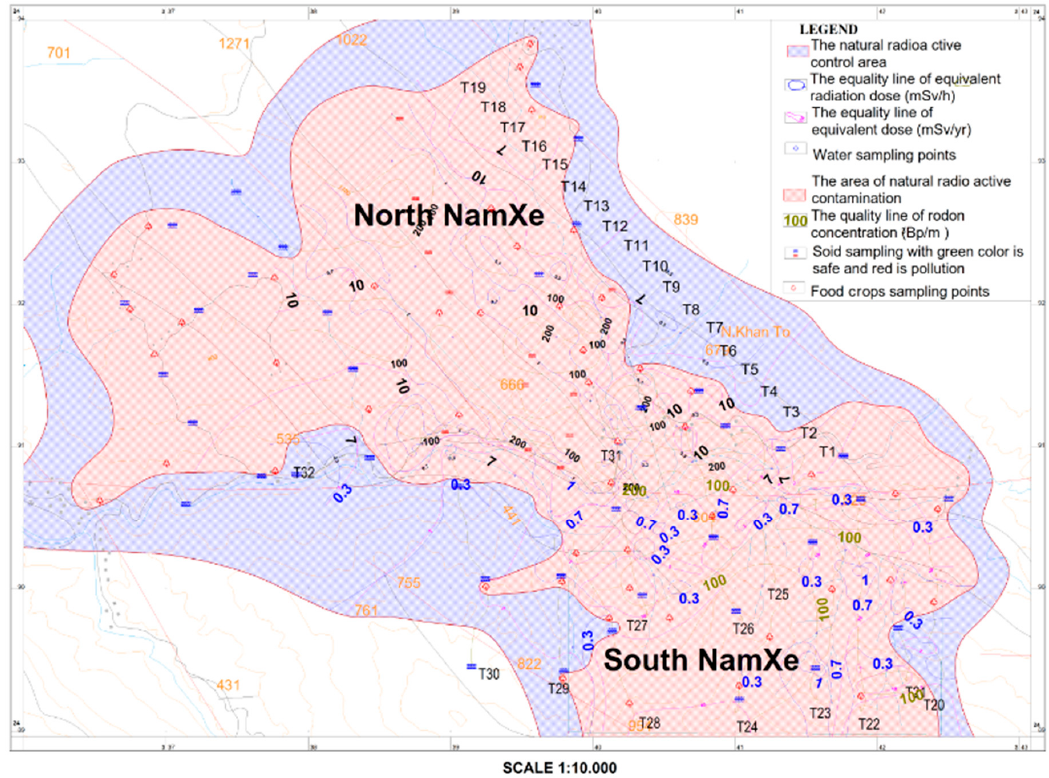
Figure 2. Map of delineating area contaminated by natural radiation in Nam Xe rare earth deposit.